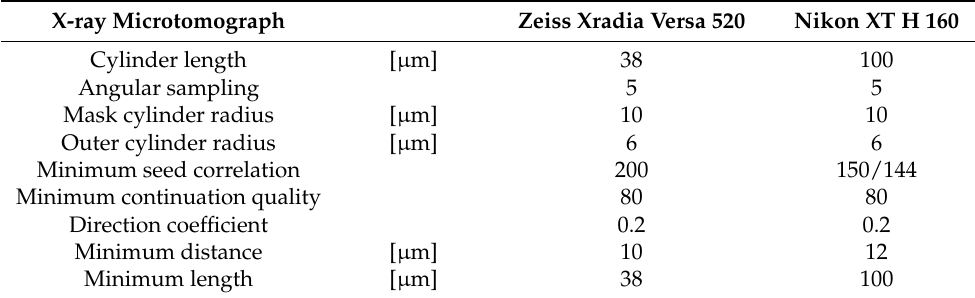
Table 3. XFiber extension settings (Avizo 9.4) depending on the origin of µ CT 3D data (Nikon/Zeiss microtomograph).